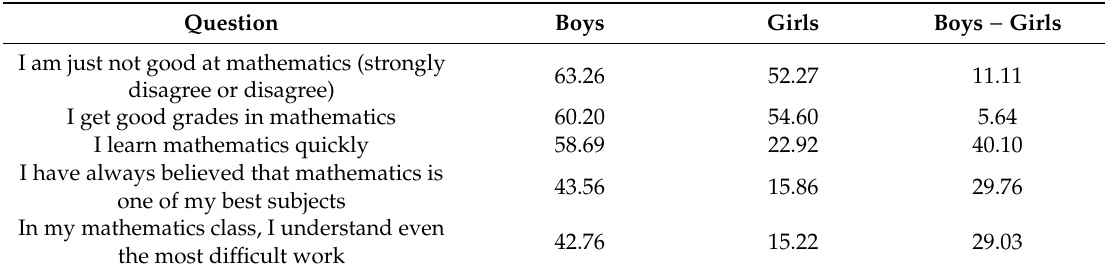
Table A6. Math Self-Concept PISA Questions.